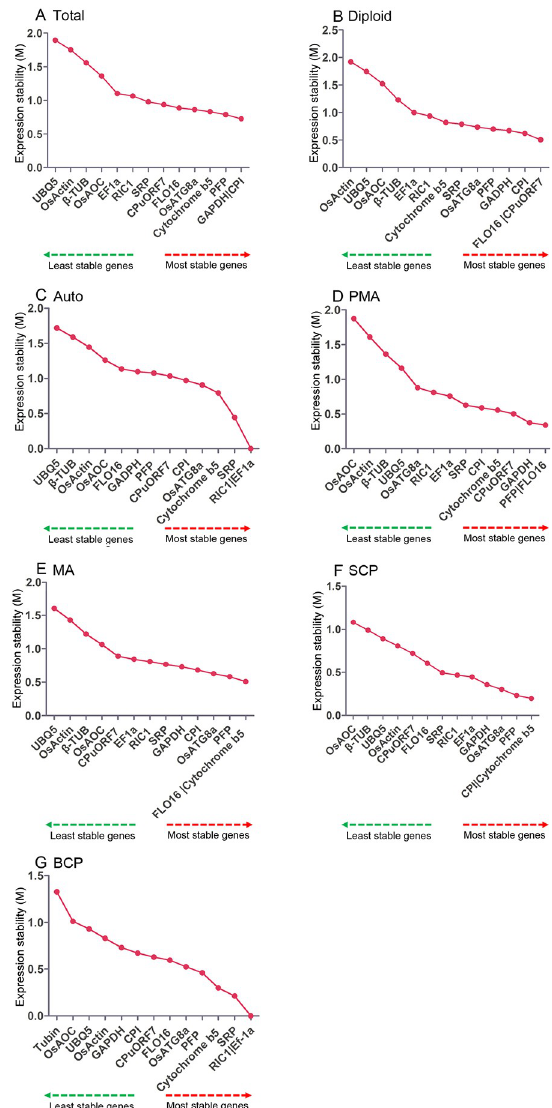
Fig 4. Stability analysis of candidate reference genes using the geNorm software. (A) All samples of autotetraploid and diploid rice. (B) All samples of diploid rice. (C) All samples of autotetraploid rice. (D) Samples of pre-meiosis stage in diploid and autotetraploid rice. (E) Samples of meiosis stage in diploid and autotetraploid rice. (F) Samples of single microspore stage in diploid and autotetraploid rice. (G) Samples of bicellular pollen stage in diploid and autotetraploid rice. Total indicate the all samples of diploid and autotetraploid rice. Diploid indicate the all samples of diploid rice; Auto indicate the all samples of autotetraploid rice; PMA indicate the samples of pre-meiosis stage in diploid and autotetraploid rice; MA indicate the samples of meiosis stage in diploid and autotetraploid rice; SCP indicate the samples of single microspore stage in diploid and autotetraploid rice; BCP indicate the samples of bicellular pollen stage in diploid and autotetraploid